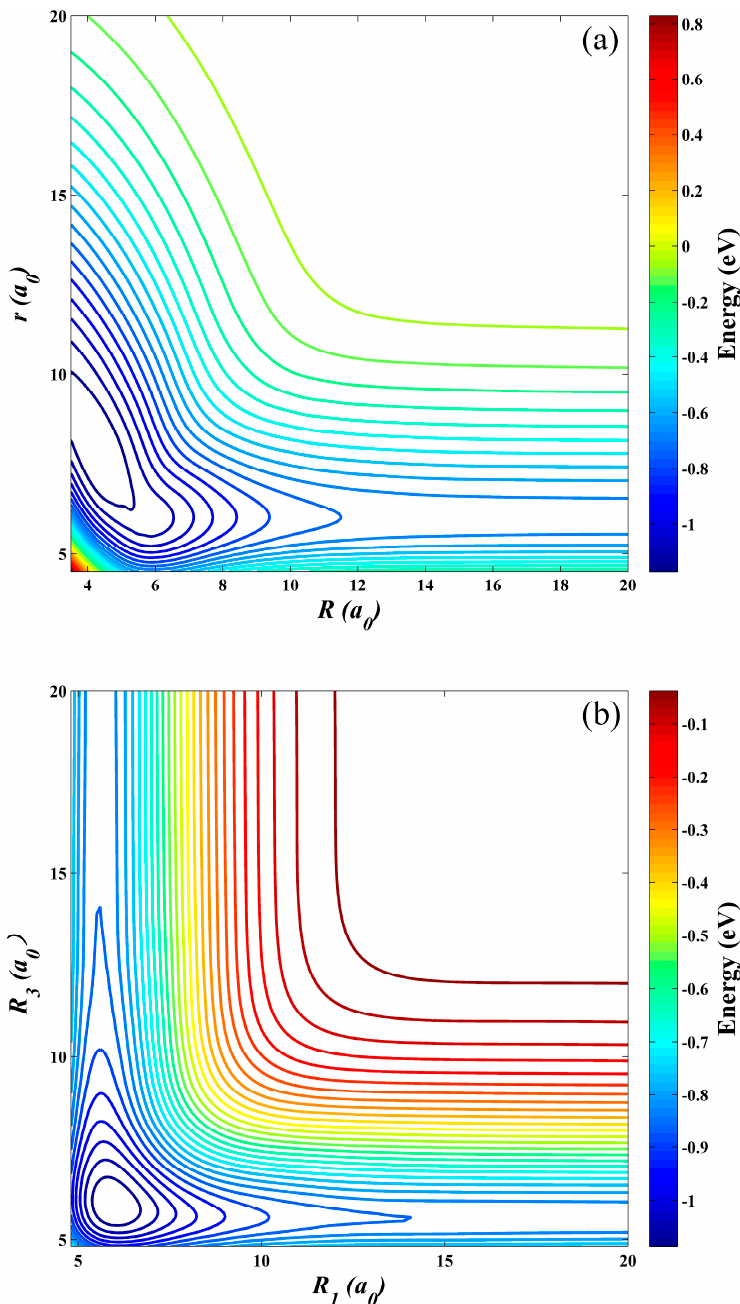
Figure 3. Contour plots of the ground-state LiNa 2 PES at C 2v ( a ) and D ∞ h ( b ) symmetries. Three − dimensional diagrams and the corresponding contour maps of the ground − state LiNa 2 PES at fixed Li − Na − Na angles (45°, 90°, 135° and 180°) are shown in Figure 4. The resulting PES modeled by the GP model is very smooth in the whole coor- dinate space, and no non − physical well and barrier occur at large Li − Na or Na − Na bond length for each approaching angle. There is a valley at the left and a valley at the right of the LiNa 2 PES with the fixed Li − Na − Na angle, which correspond to the Na( 2 S) + LiNa channel and Li( 2 S) + Na 2 channel, respectively, and the two channels are connected by a potential well. The energy value of the left valley is lower than the right valley, implying that the Li( 2 S) + Na 2 → LiNa + Na reaction is exothermic. It can be seen that the topographic